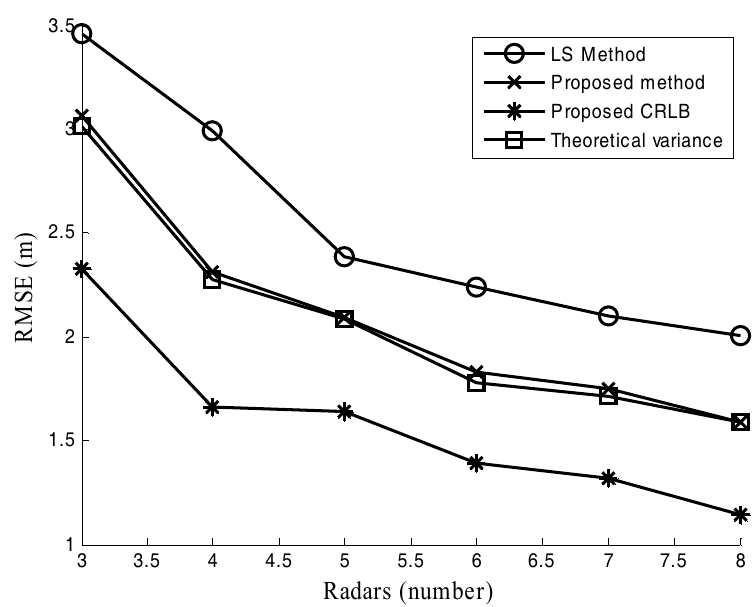
Figure 6. Positioning error under different numbers of radars.